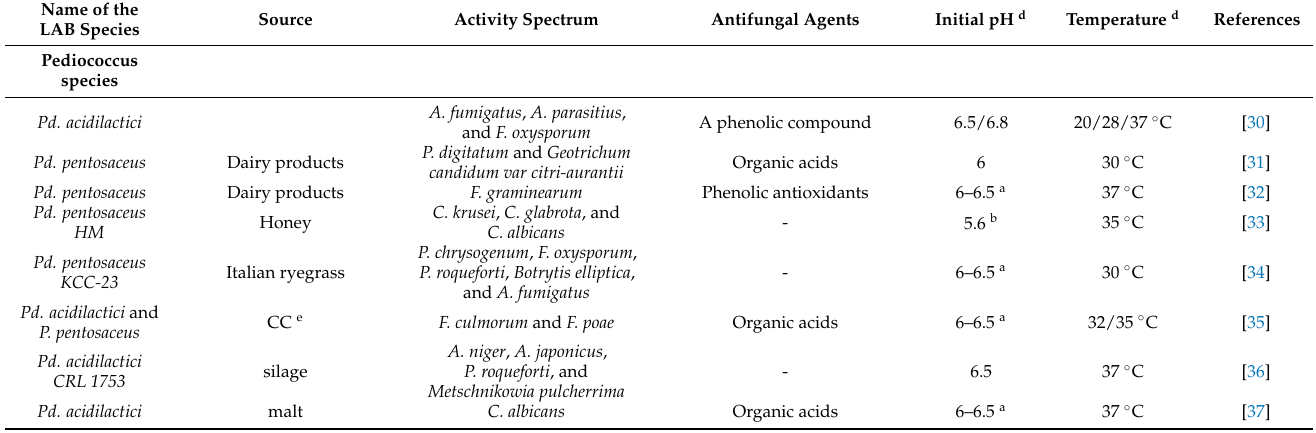
Table 2. LABs that produce antifungal